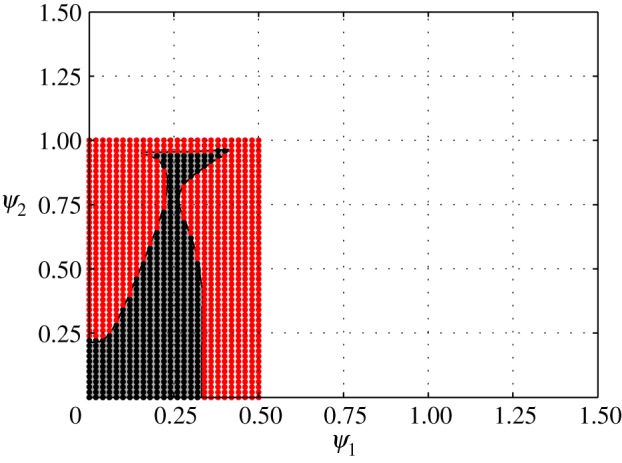
Direct numerical solution of equation (B 1) with κs=0.2, γs=0.15, δ1/ψ1=1 and δ2/ψ2=0.2. Solid line marks the stability boundary found by examining the solutions of (B 22); red and black dots mark diverging and converging solutions of (B 1).